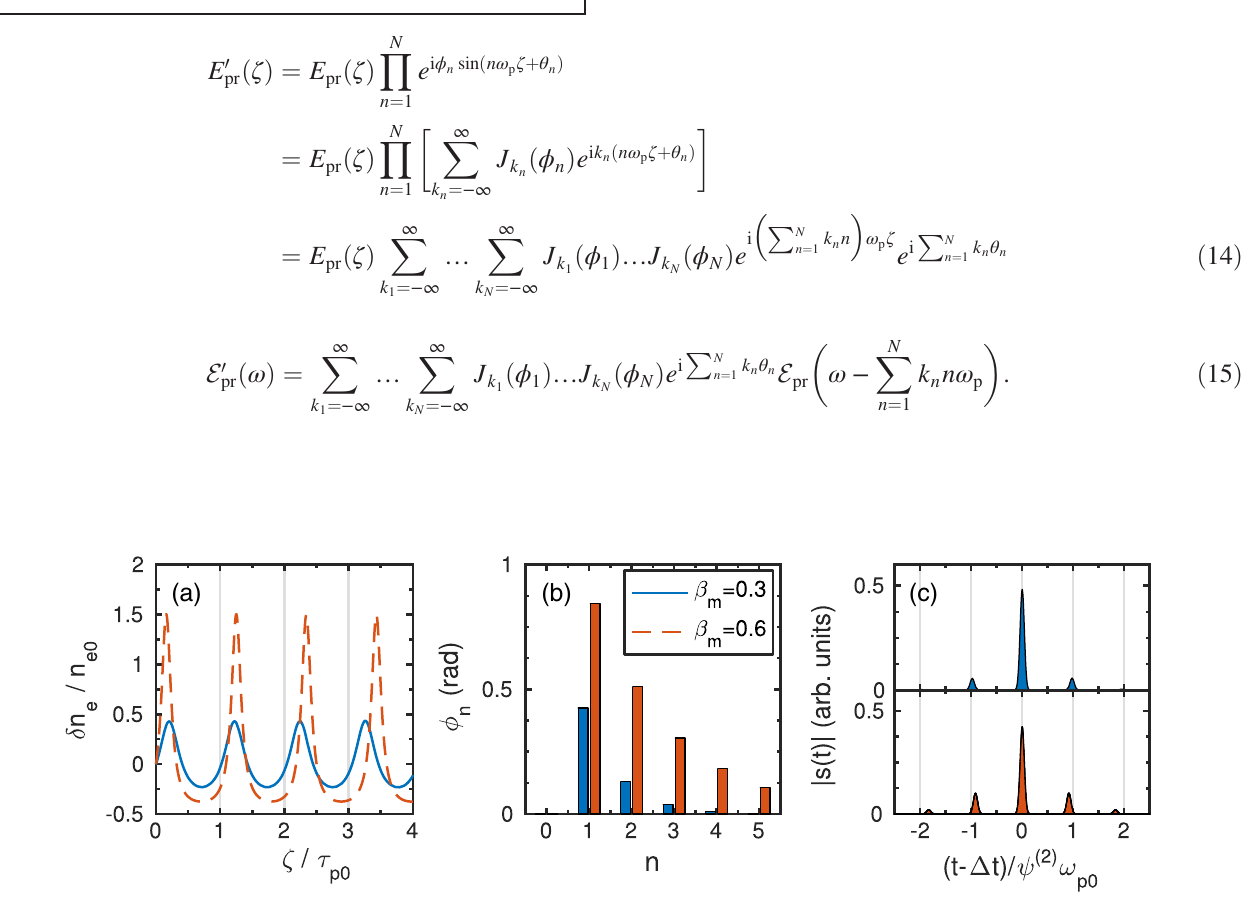
0 . 3 (blue) and β 0 . 6 (red). m ¼ m ¼ 0 . 3 (blue) m ¼